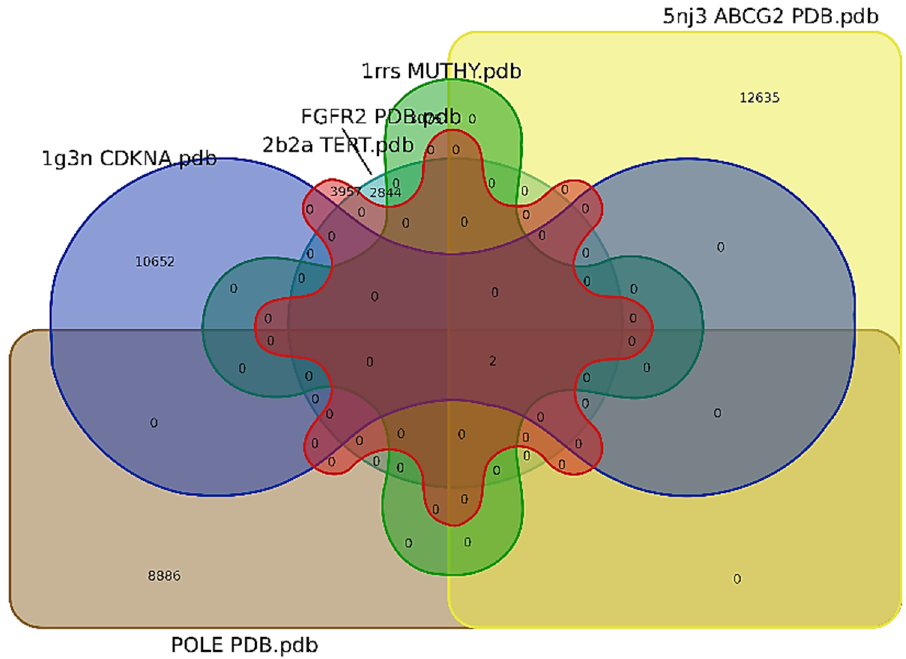
Figure 11. A Venn diagram showing the intersection of identified compounds with several elements: ABCG2 (12,635), CDKNA (10,652), POLE (8886), FGFR2 (2844), TRET (3957), and MUTHY (3075).